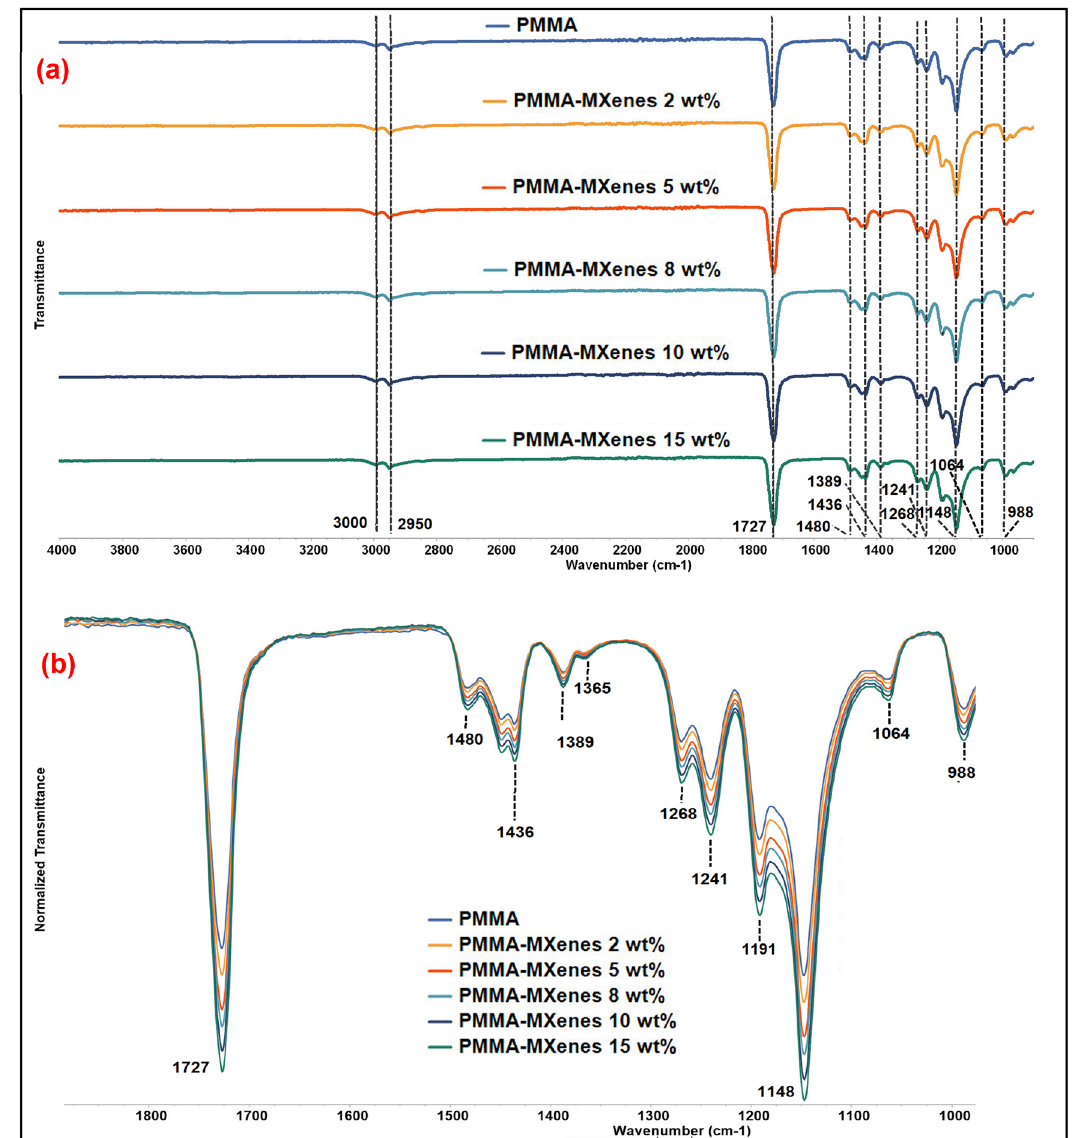
Figure 5: FTIR spectra for all samples in di ff erent presentation modes. ( a ) FTIR spectra are stacked to each another. ( b ) FTIR spectra with normalized